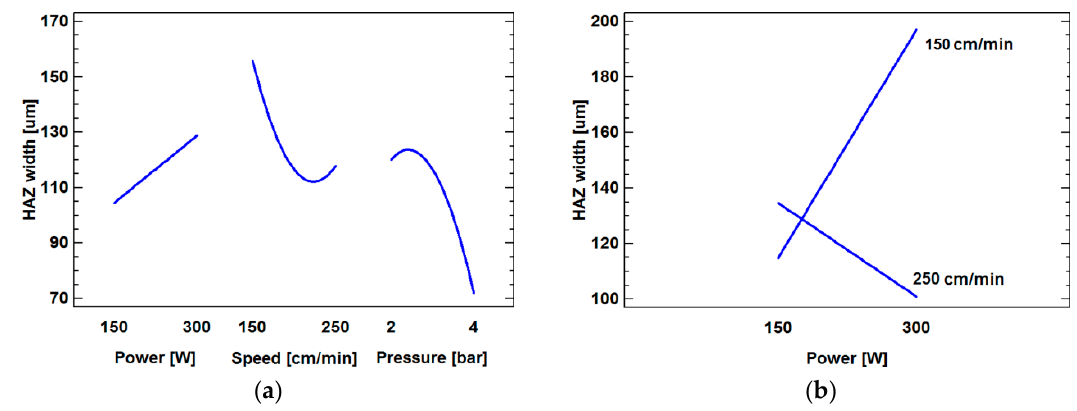
Figure 12. ( a ) Main effects and ( b ) interaction plots of HAZ width. Polynomial trendlines have been used to fit perpendicularity tolerance data.